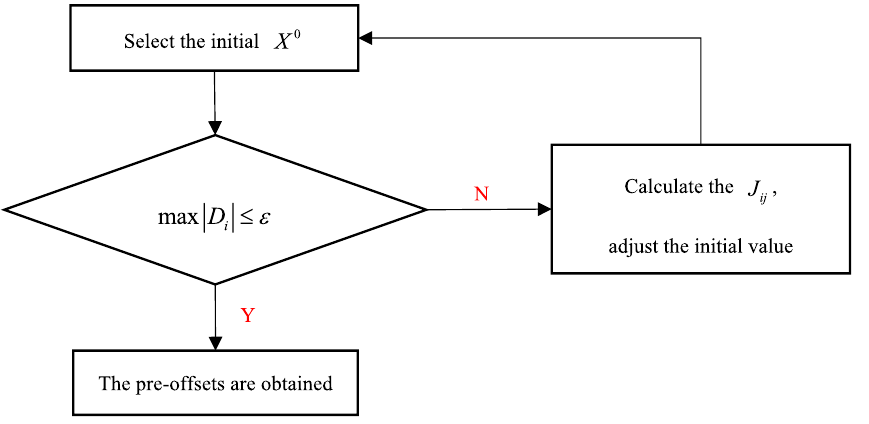
Figure 7. Algorithm flow of the tower and splay saddle